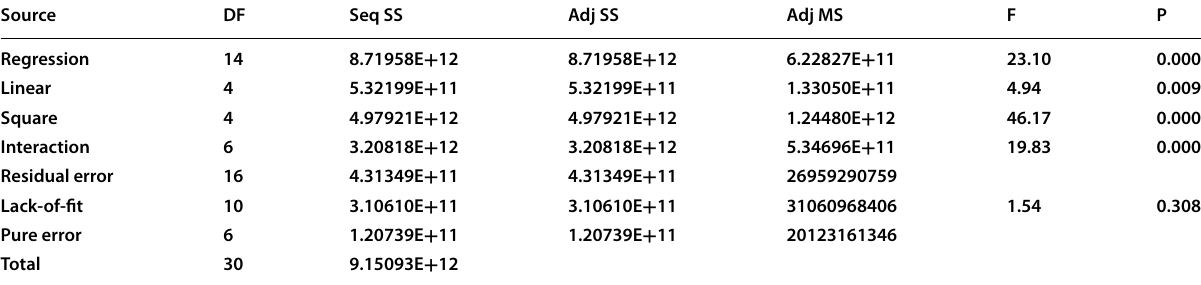
For checking the accuracy of the model, normal prob- ability plot and residual plots were evaluated. The normal Table 9 ANOVA of the quadratic polynomial model for BL of Vibrio sp. 6HFE